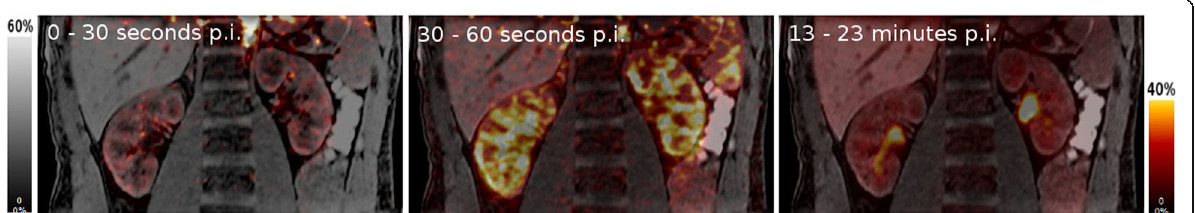
Fig. 1 Images of FDG distribution in certain periods after injection (p.i.) obtained from a dynamic renal PET scan after image fusion with an MRI sequence